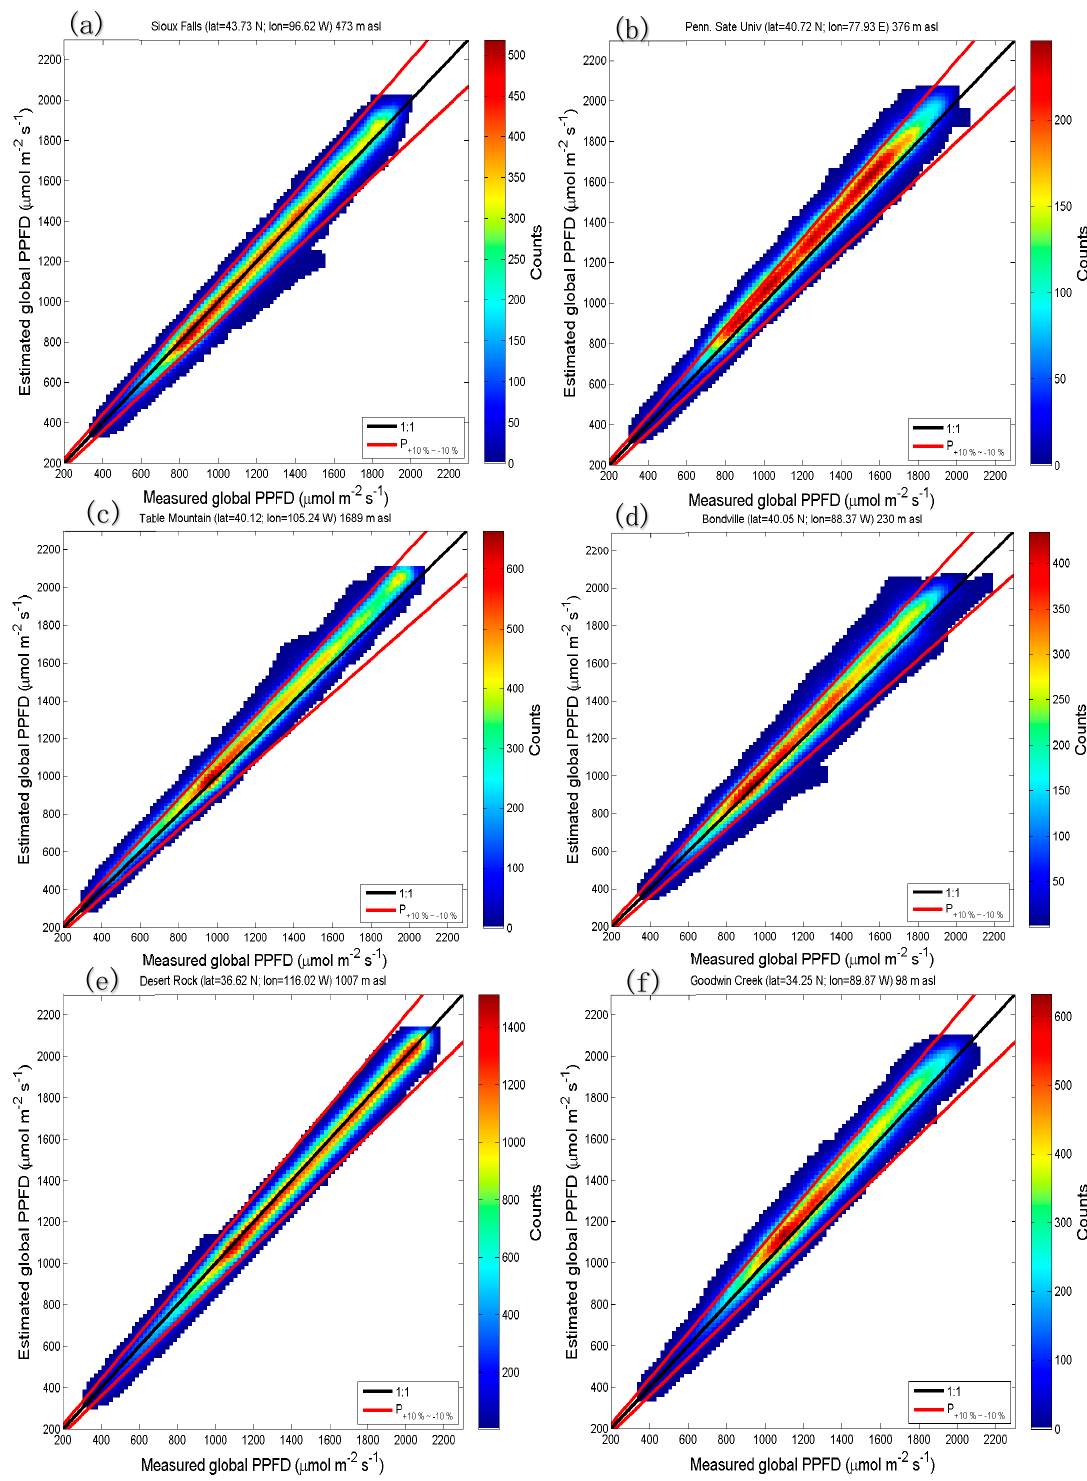
Figure 4. 2D histogram of the measured PPFD and estimates in cloudless atmospheres at each station except Fort Peck: ( a ) Sioux Falls; ( b ) Penn. State Univ.; ( c ) Table Mountain; ( d ) Bondville; ( e ) Desert Rock; ( f ) Goodwin Creek. The color bar indicates the number of couples in each bin of 20 µ mol m − 2 s − 1 in width.